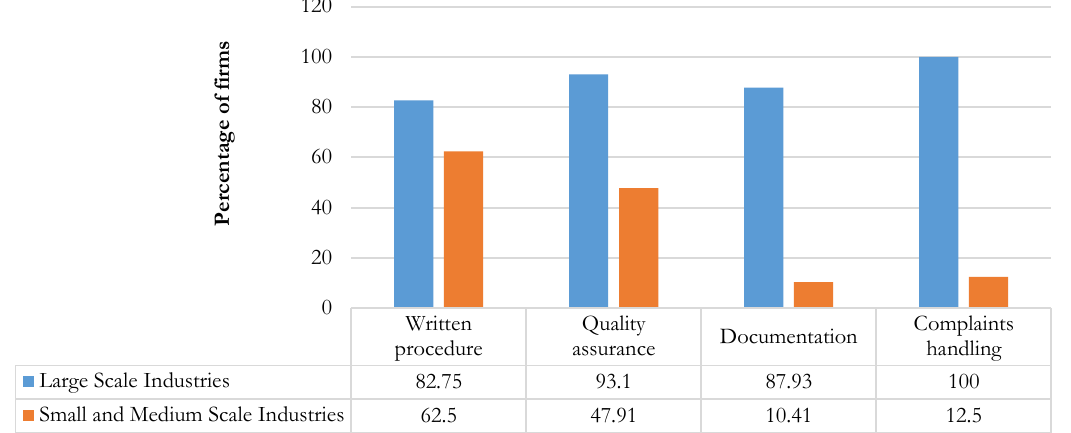
Fig. 8. Quality assurance tools: a comparison between both groups of firms.